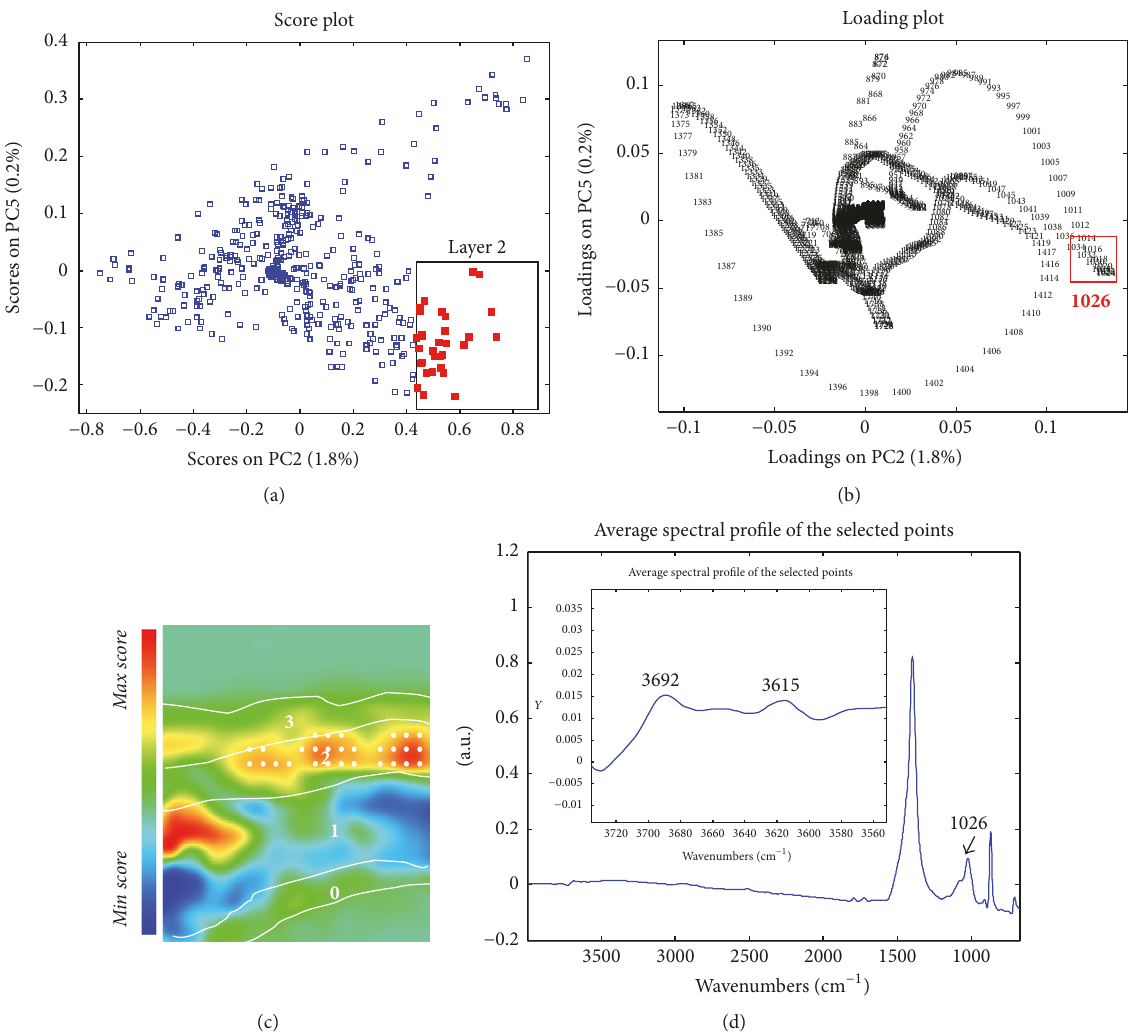
Figure 7: Sample PO1. (a) PC25 score plot: cluster highlighted in red indicate the objects localised within the PC2 score map (layer 1); (b) PC25 loading plot; (c) PC2 score map: The white points indicate objects localised within layer 1; (d) average spectral profile extracted from layer